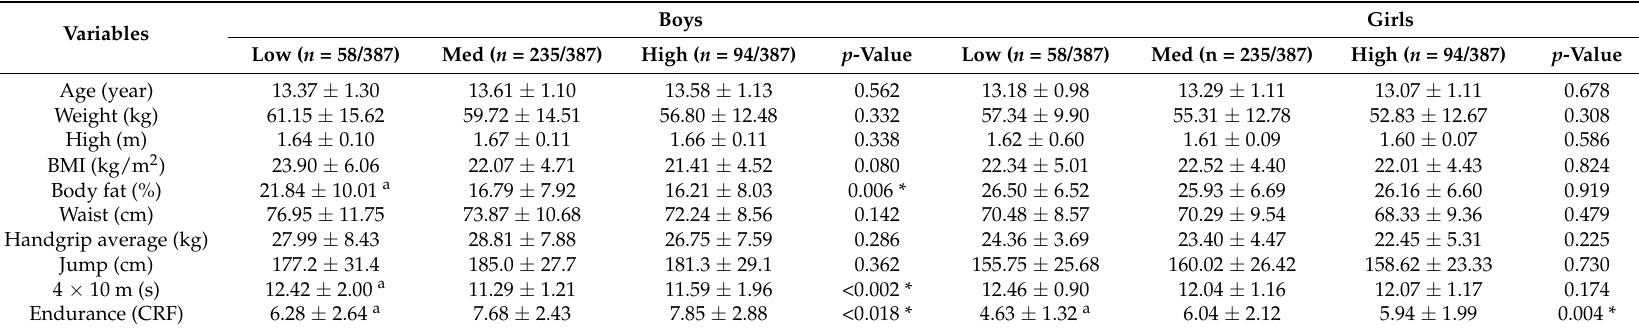
Table 2. Anthropometric characteristics and physical fitness variables of the sample stratified according to adherence to MD in both boys and girls (Data presented as Mean ±